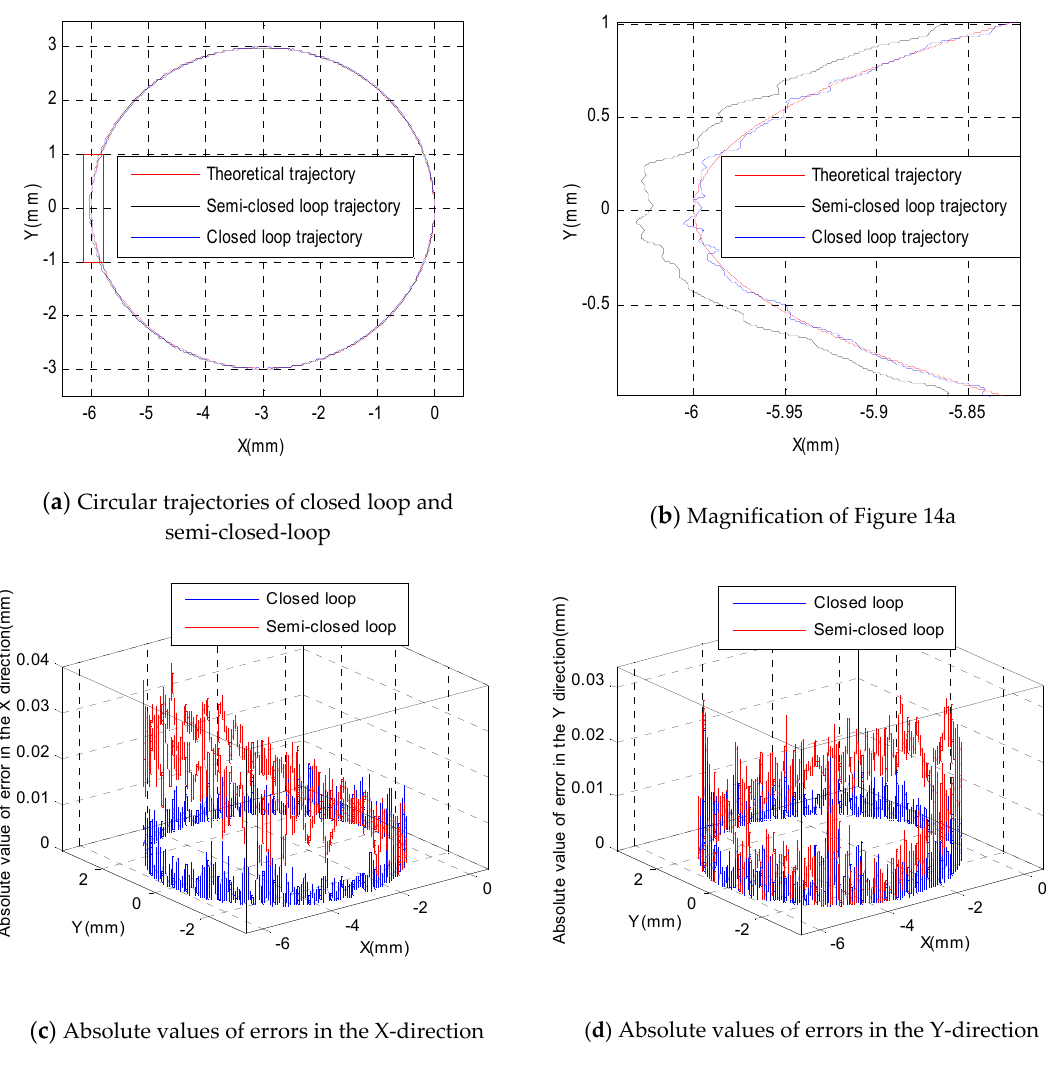
K K = = . Figure 14. Circular trajectory tracking with a PI controller, K p = 0.5, K i = p i